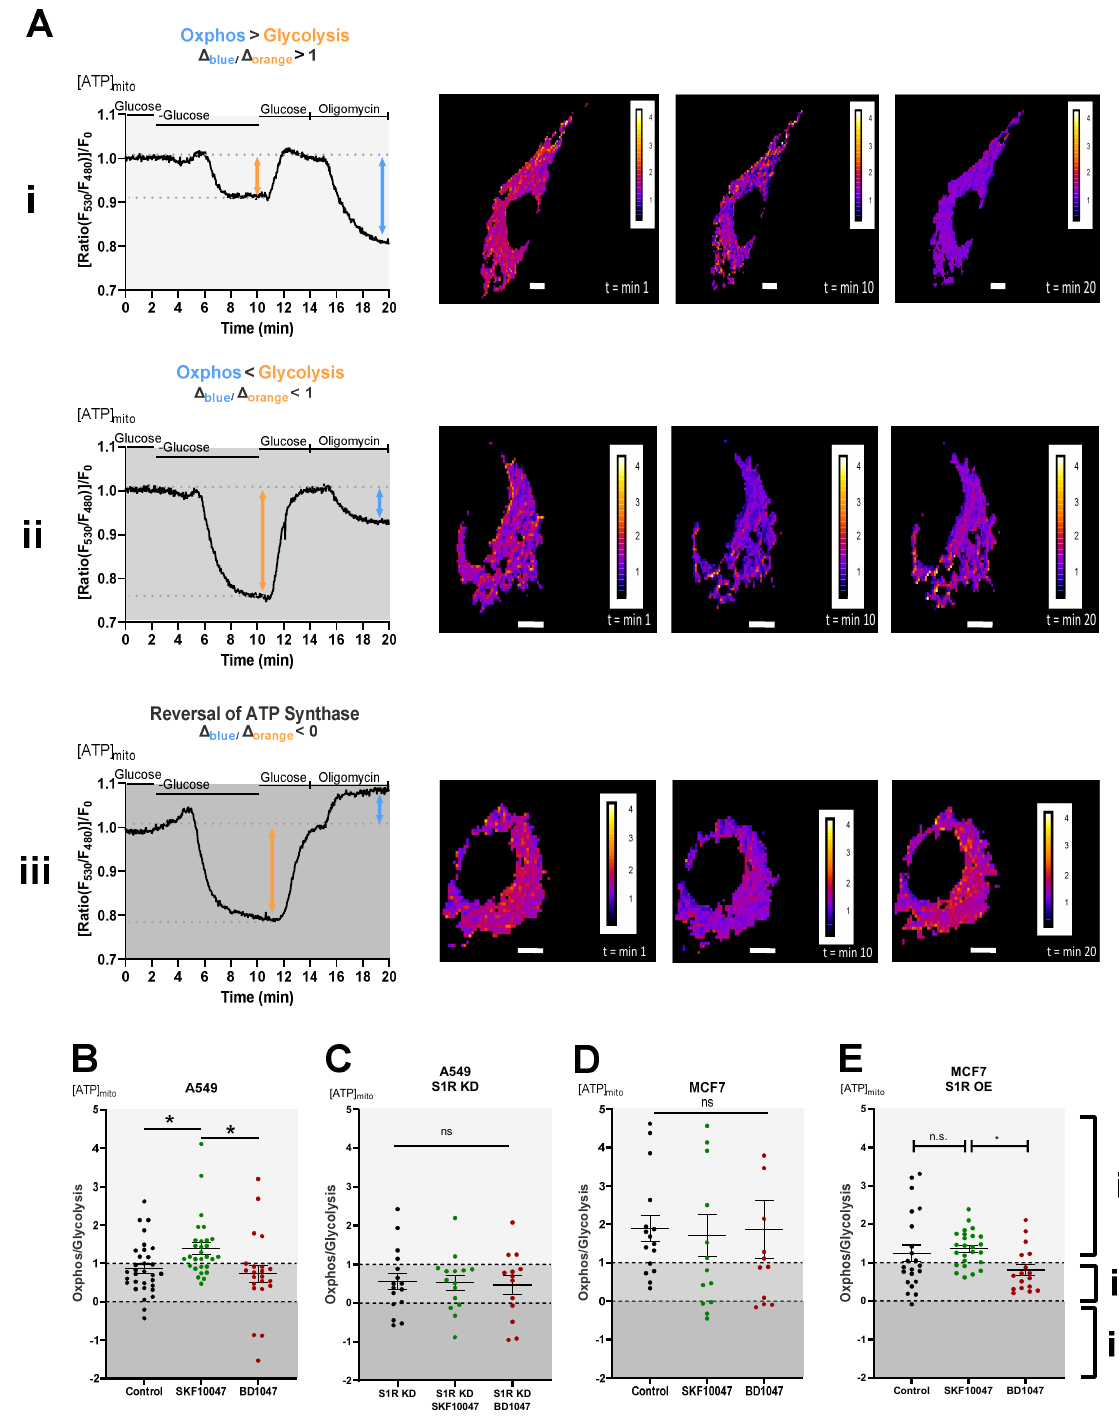
Figure 2. Effect of pharmacological activation of S1R on mitochondrial energy status. ( A ) Repre- sentative traces of mitochondrial ATP levels with corresponding representative images of the cells transfected with mtAT.1.03 in MCF7 ( i ) and A549 ( ii , iii ) cells. The cells have been pseudocolored to represent mitochondrial ATP level as mtAT1.04 ratio; calibration bars are inserted on the right-hand side of the cells. The inserted white scale bar represents 10 µ m. Change in ratio of oligomycin addition to glucose deprivation was used as a Oxphos/Glycolysis ratio and presented as Oxphos > Glycolysis ( A ( i )), Oxphos < Glycolysis ( A ( ii )), and reversal of ATP synthase ( A ( iii )). White area in panels ( B – E ) (indicated with ( i )) represents Oxphos > Glycolysis, light gray area in panels ( B – E ) (indicates with ( ii )) represents Oxphos < Glycolysis, and dark gray area in panels ( B – E) (indicated by ( iii ))